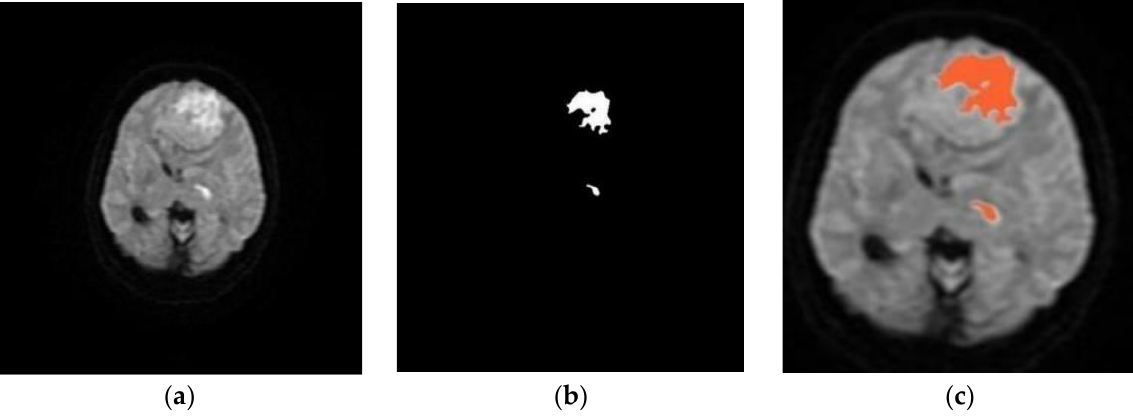
Figure 4. Original DWI image ( a ), and morphological binary image ( b ), detected infarct marked as red ( c ) [78].